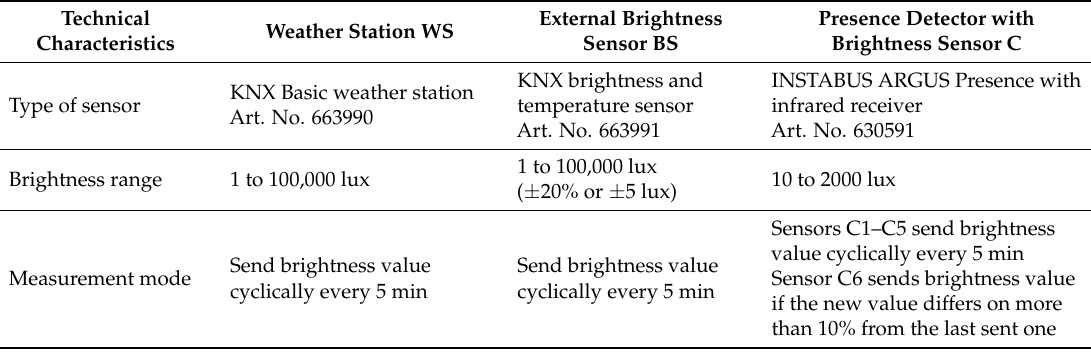
Table 3. Technical characteristics of the brightness